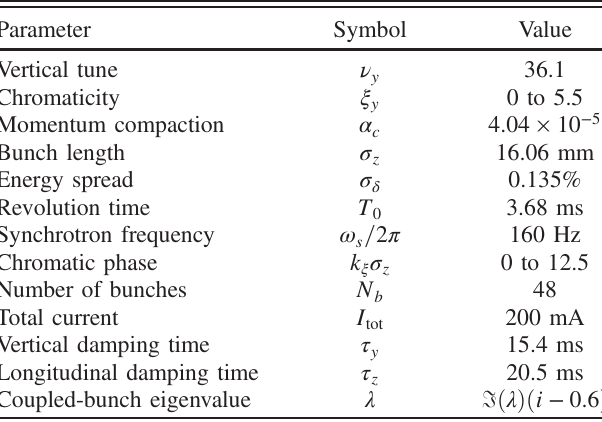
TABLE I. Parameters used in ELEGANT simulations.